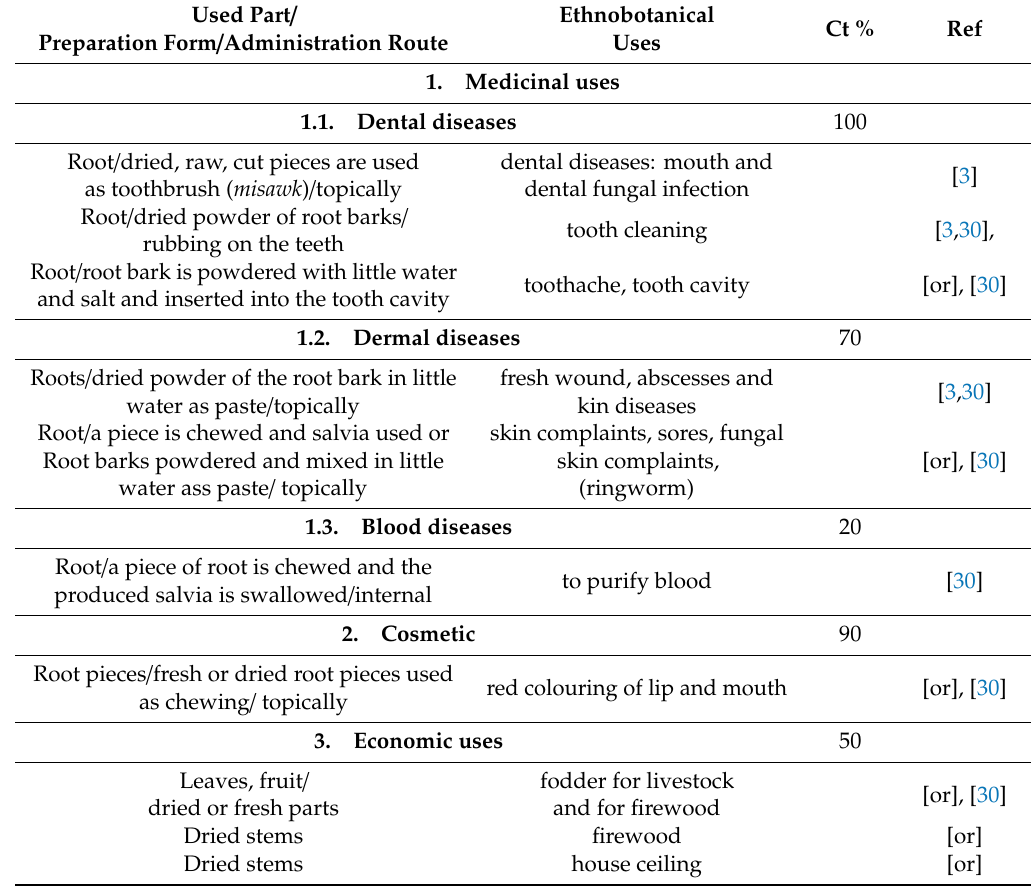
Table 2. Data of ethnobotanical survey of Euclea divinorum on Soqotra Island. Used Part